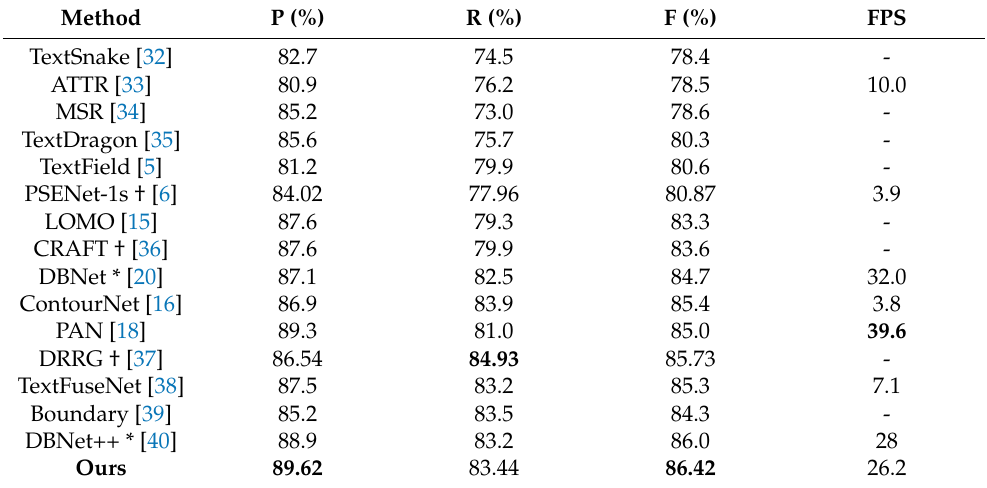
Table 2. Detection results on the Total-Text dataset. “ ∗ ” indicates using deformable-ResNet-50 as backbone and “†” indicates using external MLT17 data for pre-training. The best results of all measures are bold.